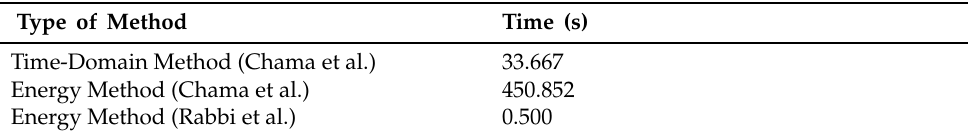
Table 2. Computational time to determine test machine’s x cr per method. Type of Method Time (s) Time-Domain Method (Chama et al.) 33.667 Energy Method (Chama et al.) 450.852 Energy Method (Rabbi et al.)